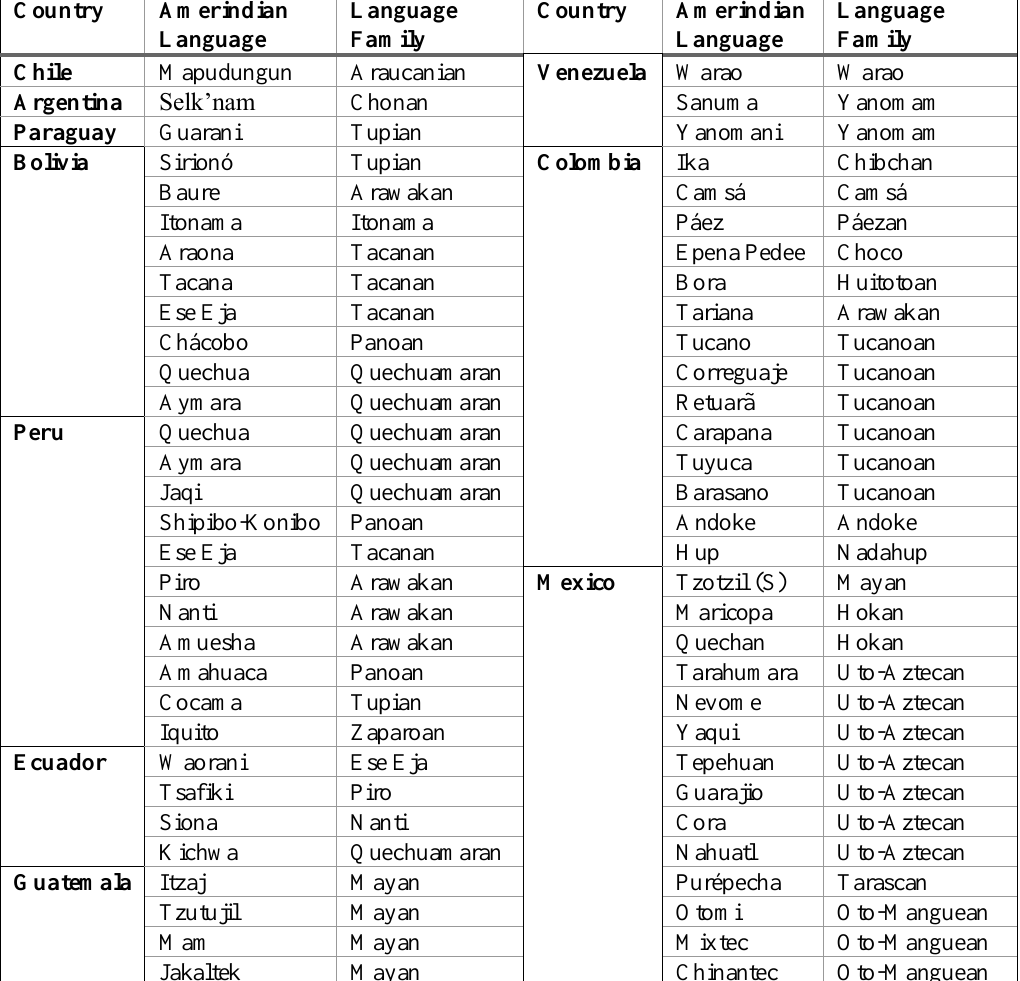
Table 1. Amerindian languages with evidential grammatical systems